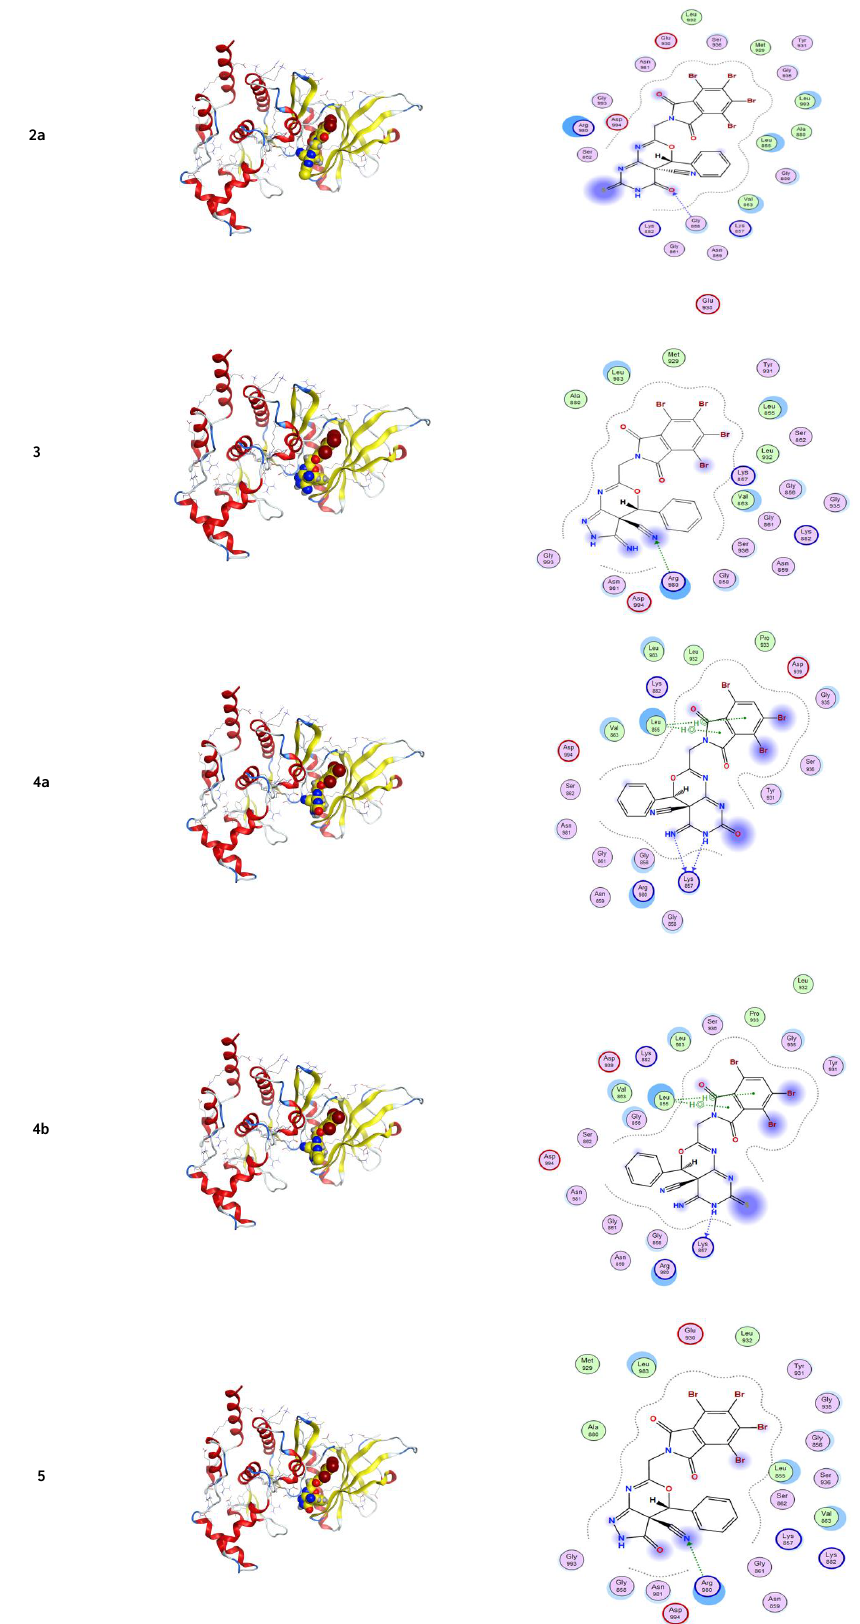
Figure 4. 3D and 2D snapshots show the hydrophilicity interaction to the MCF-7 breast target (3 KRR) receptor.